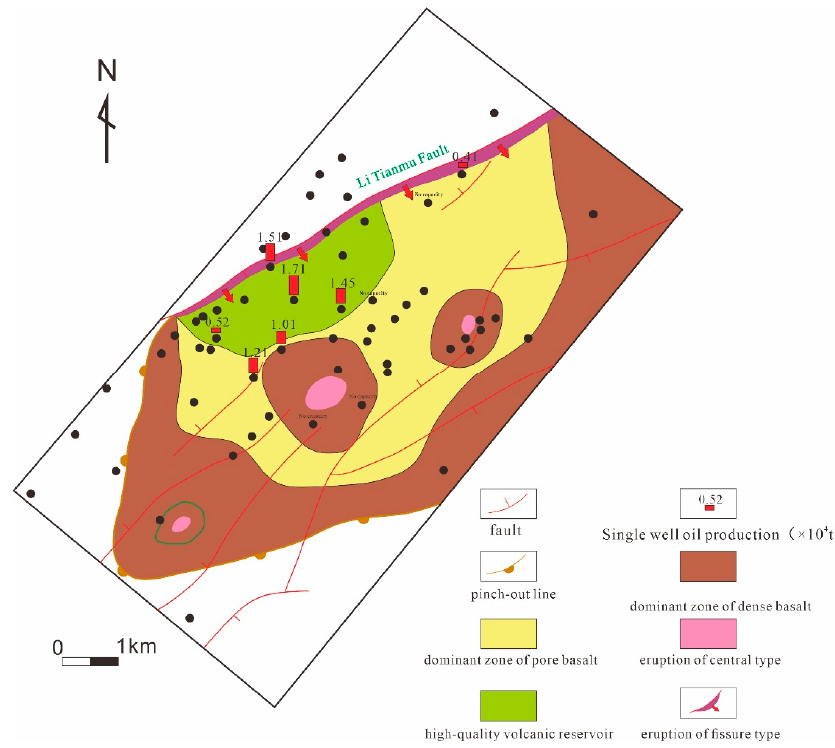
Figure 11. Distribution map of single well cumulative production in the Zao35 fault block.